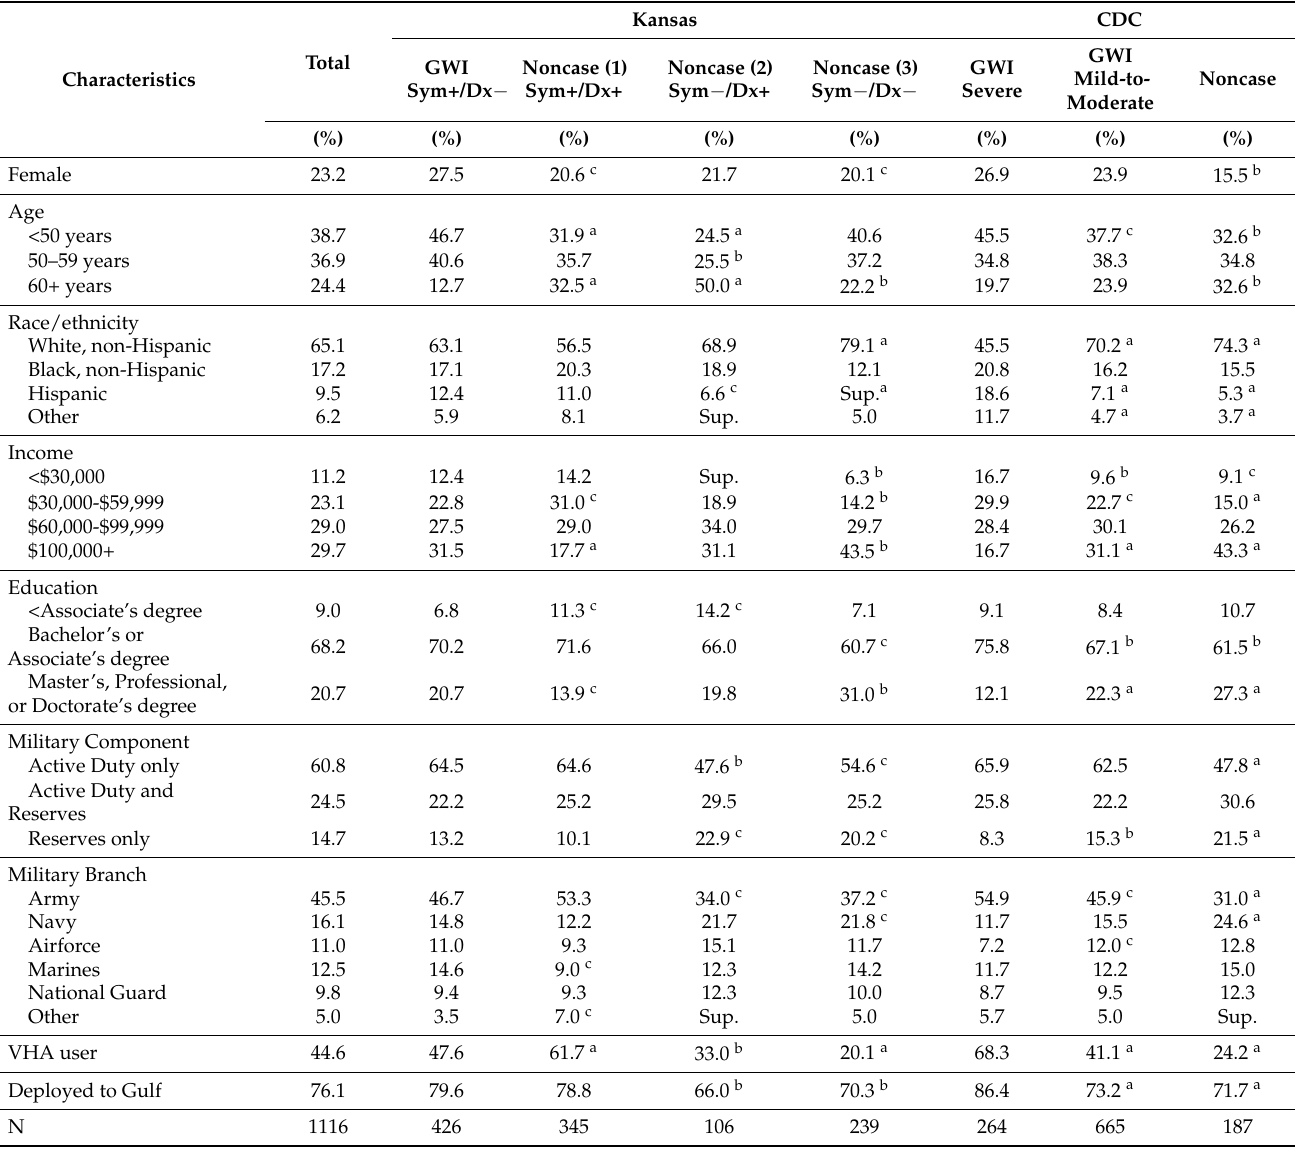
Table 1. Descriptive Statistics by Gulf War Illness Case